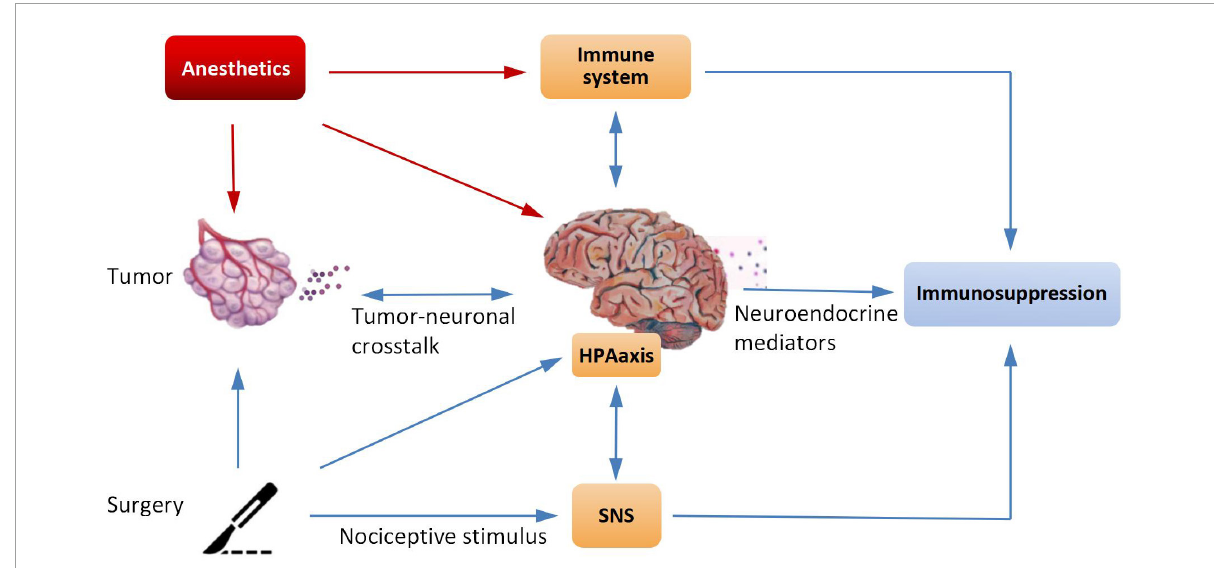
FIGURE2 Anesthetics have effects on tumors, the nervous system, and the immune